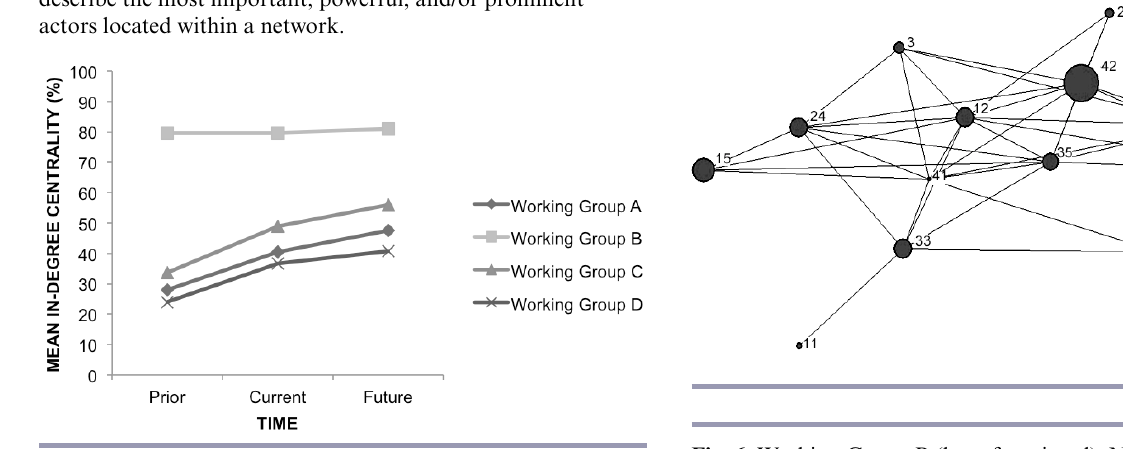
Fig. 6 . Working Group B (least functional). Nodes represent individual working group members. Node size represents the member’s in-degree centrality. A larger node indicates a higher in-degree centrality value for that member and, thus, more prominence within the